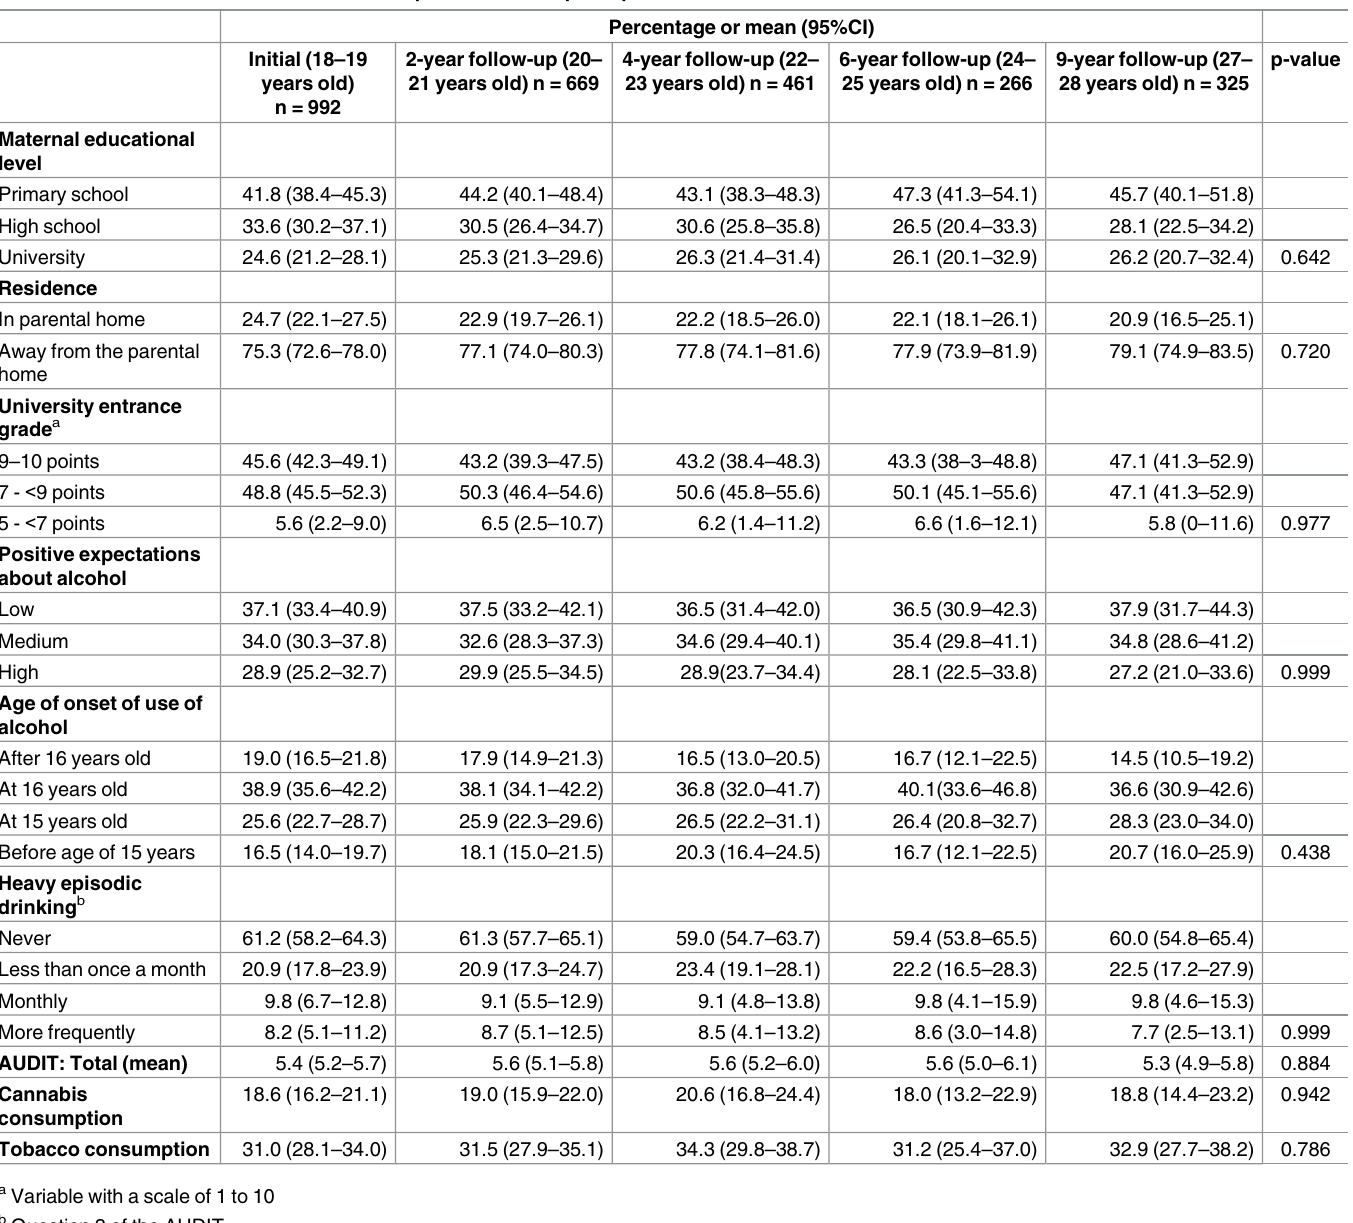
Table 1. Characteristics of female initial sample and follow-up